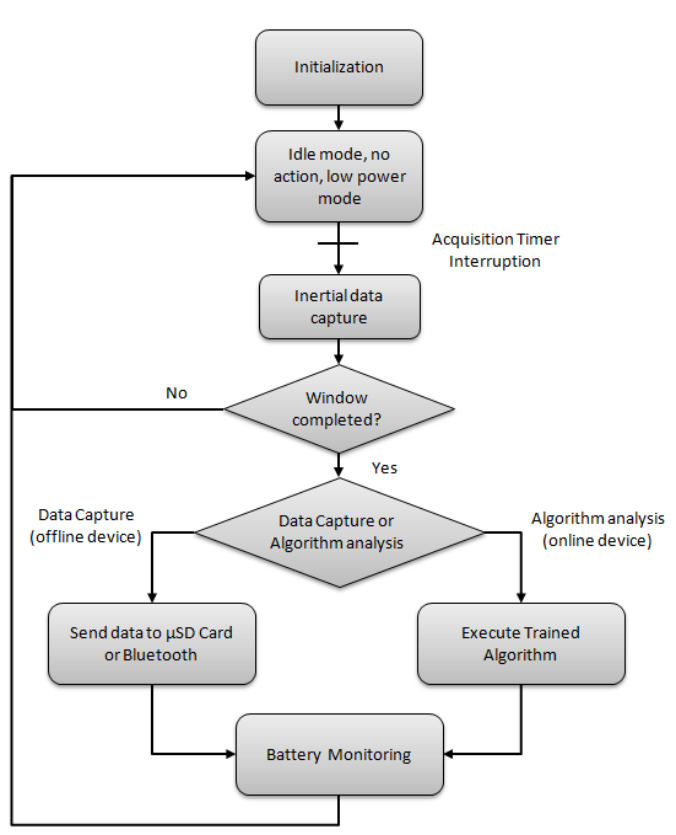
Figure 6. Firmware